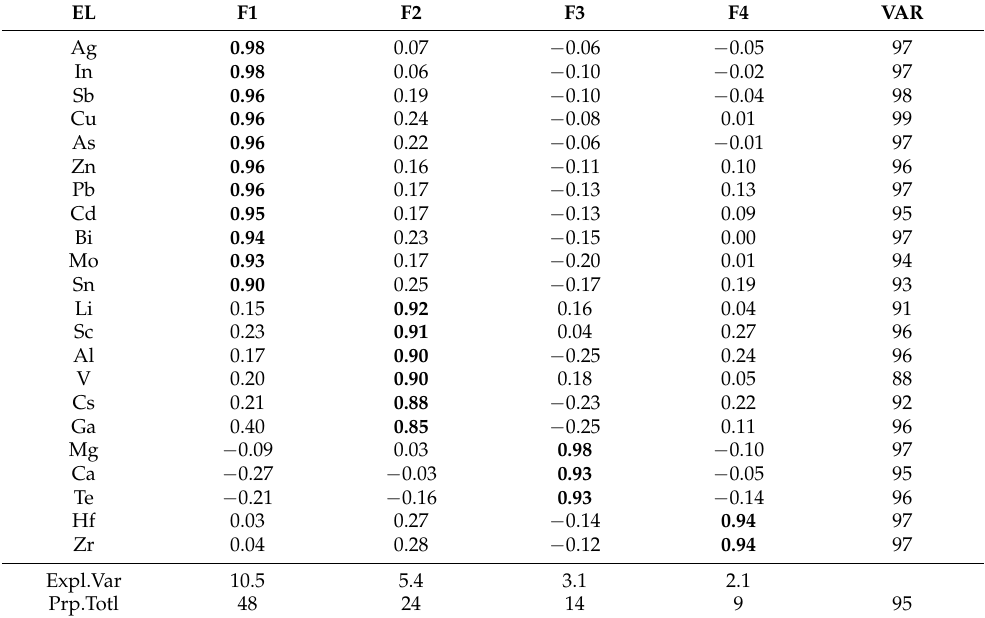
Table 2. Factor loadings in factor analysis.